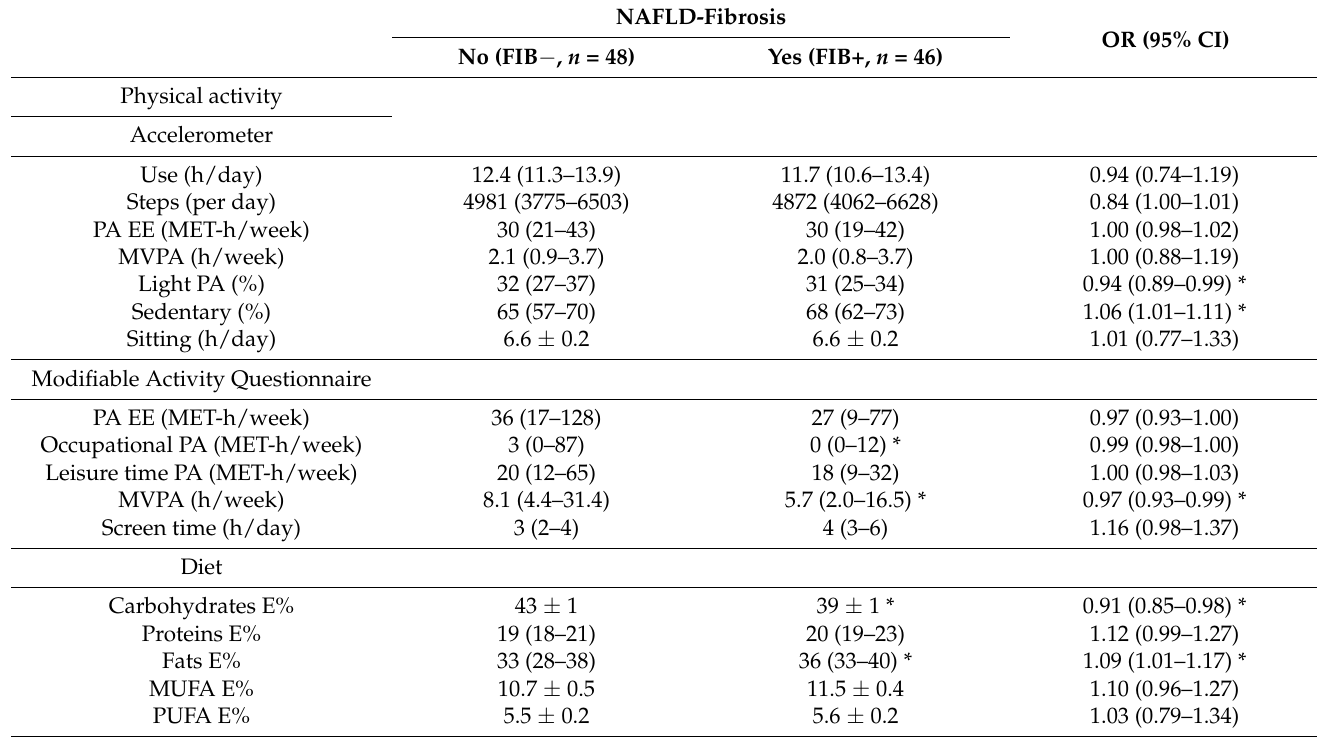
Table 1. Lifestyle characteristics of the participants without (FIB − ) and with (FIB+) NAFLD-fibrosis, and univariable analysis to predict